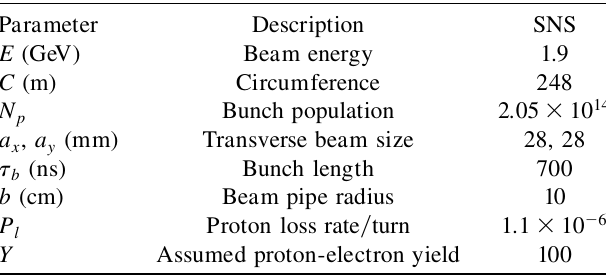
TABLE I. Simulation parameters for the